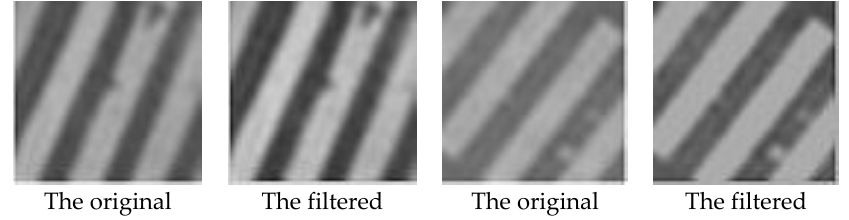
Figure 2. The samples of zebra crossing images before and after the Wallis filter.